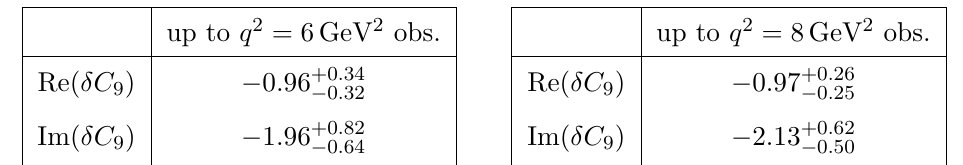
Table 1 . Fit results for (cid:14)C 9 alone using observables up to q 2 = 6 GeV 2 as well as up to q 2 = 8 GeV 2 .